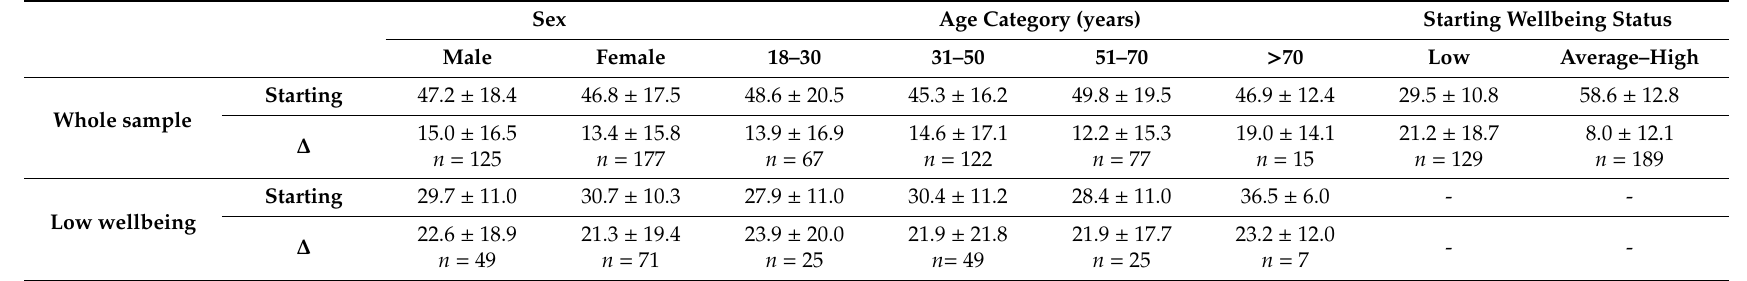
Table 3. Mean ± SD starting and ∆ normalised percentage values of respective scales by age category, sex and starting wellbeing